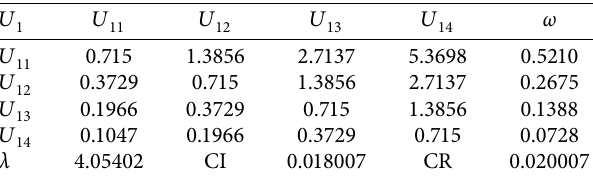
Table 5: Indicator judgement matrix and the weights of the po- litical risk.